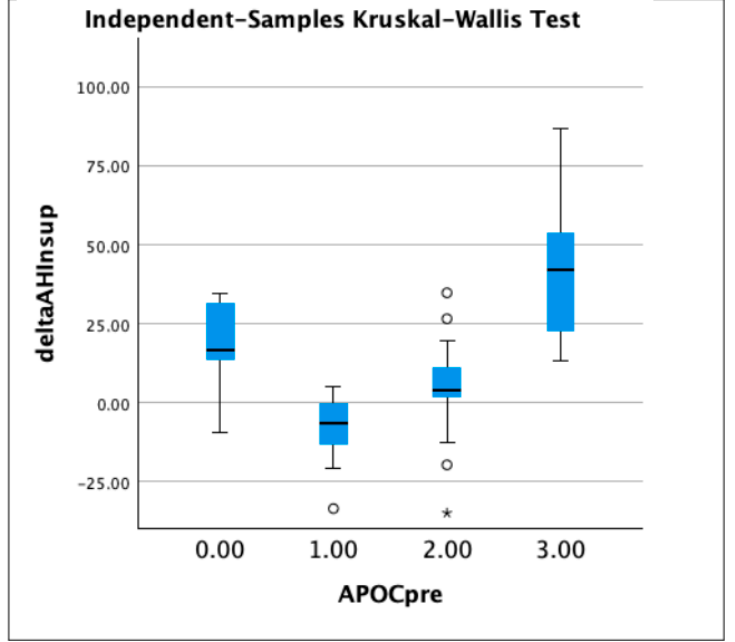
Figure 5. Boxplots showing delta AHI non supine in patients divided in groups according to APOC classification (group 0 stands for non ‐ classifiable APOC; 1.00 = APOC 1, 2.00 = APOG 2, and 3.00 = APOC 3). Asterisk and circles represent outliers.